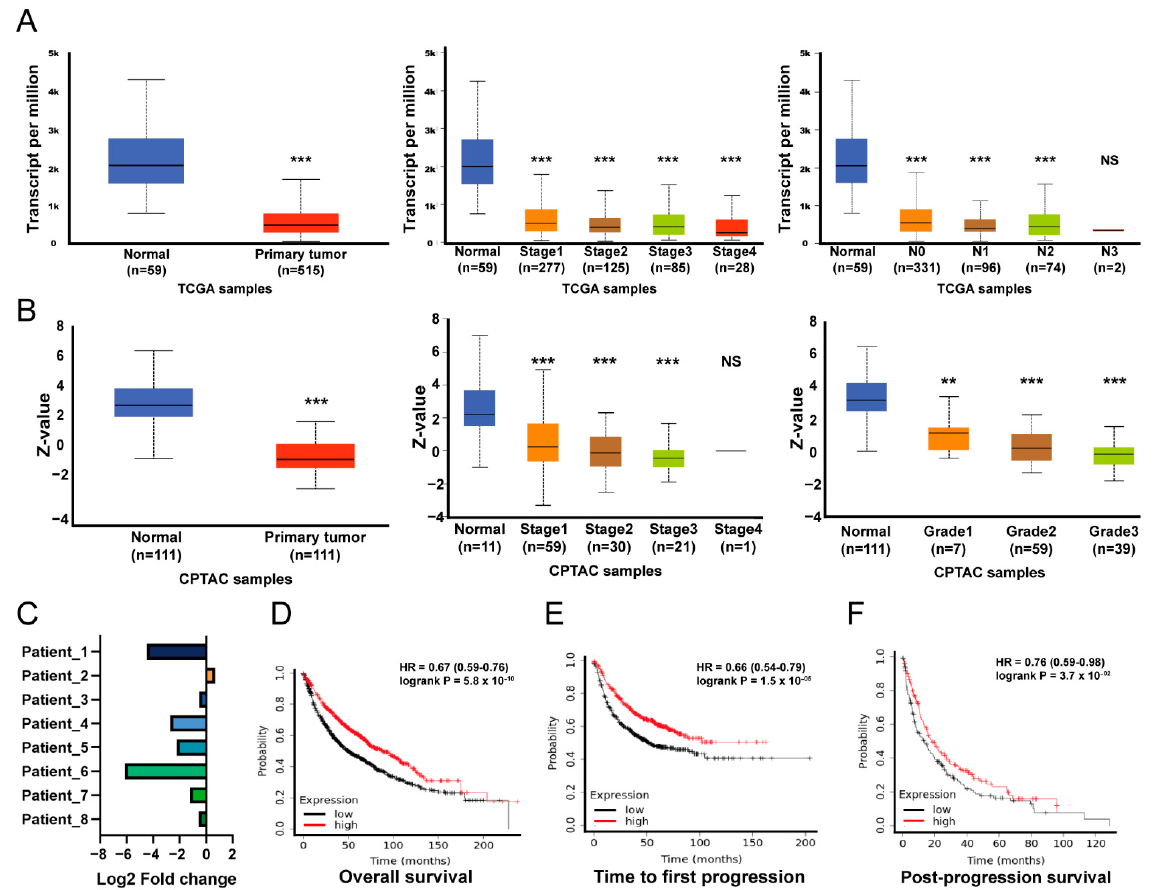
Figure 4. Tumor characteristics of A2M expression and survival analysis of ADAMTS1-A2M expression in LUAD. ( A ) The expression of A2M mRNA among the normal tissue and tumor (left), the tumor stages (middle), and the nodal metastasis (right) in the TCGA cohort. ( B ) The expression of A2M protein expression among the normal tissue and tumor (left), the tumor stages (middle), and the tumor grades (right) in the CPTAC cohort. ( C ) The level of A2M in the tumor and normal tissue from eight patients with LUAD (in-house cohort). Correlation of OS ( D ), FP ( E ), and PPS ( F ) with A2M expression in patients with LUAD. (NS not significant, ** p < 0.01, *** p < 0.005).